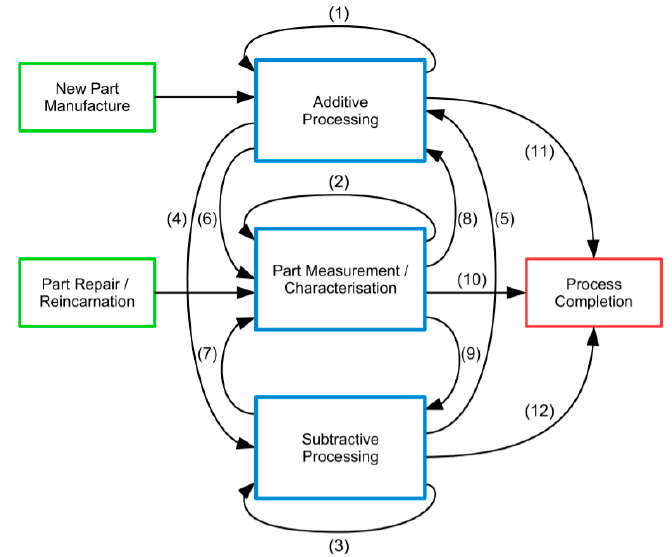
Figure 5. A closed loop of hybrid manufacturing for micro/nano-scale additive manufacturing [85].